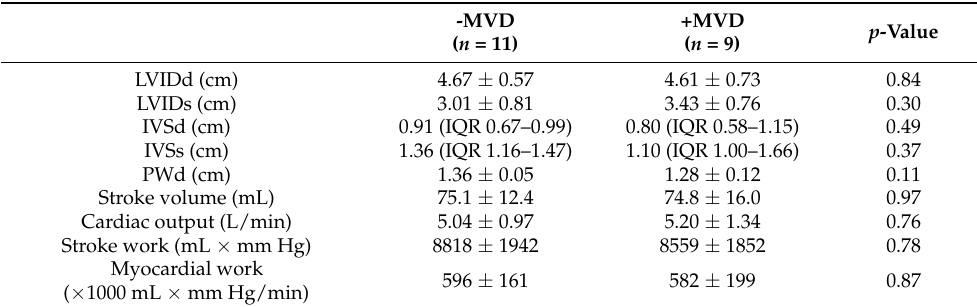
Table 2. Left ventricular morphometry and function by presence of microvascular dysfunction